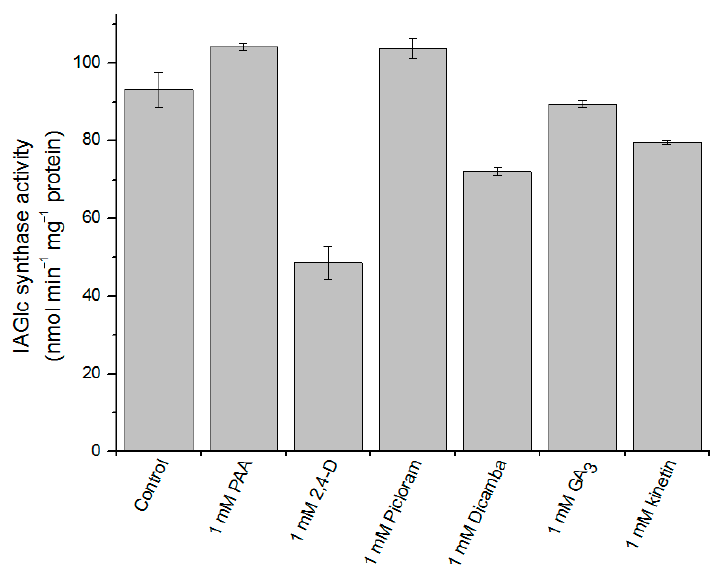
Figure 8. Effect of phytohormones on IAGlc synthase. Phytohormones that are not utilized by IAGlc synthase as substrates were used for this assay. Enzyme activity was determined using [ 14 C]IAA after TLC; the control mixture did not contain any additional phytohormones. Catalytic activity was expressed as the means ± SD for three repetitions. PAA–phenylacetic acid; 2,4-D—2,4-dichlorophenoxyacetic acid; GA 3 —gibberellic acid.